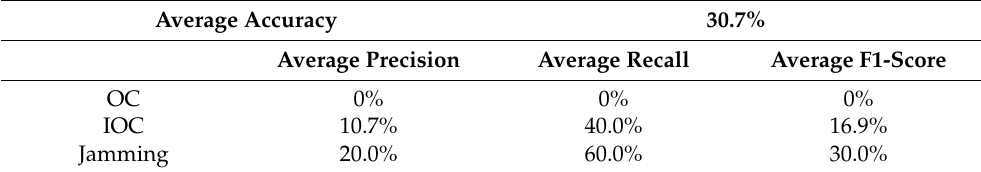
( b ) Figure 11. Confusion Matrix for TSF Model: ( a ) Case 1 — Most-Accurate Iteration; ( b ) Case 2 — Least-Accurate Iteration. Table 11. TSF Multivariate Performance. Average Accuracy